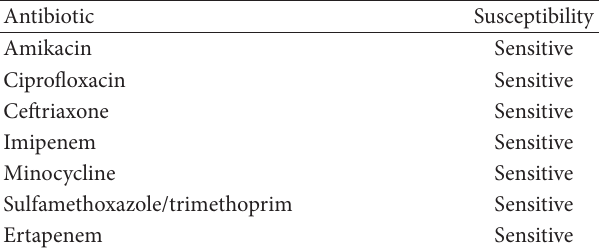
Table 1: N. beijingensis isolate antimicrobial susceptibility results.